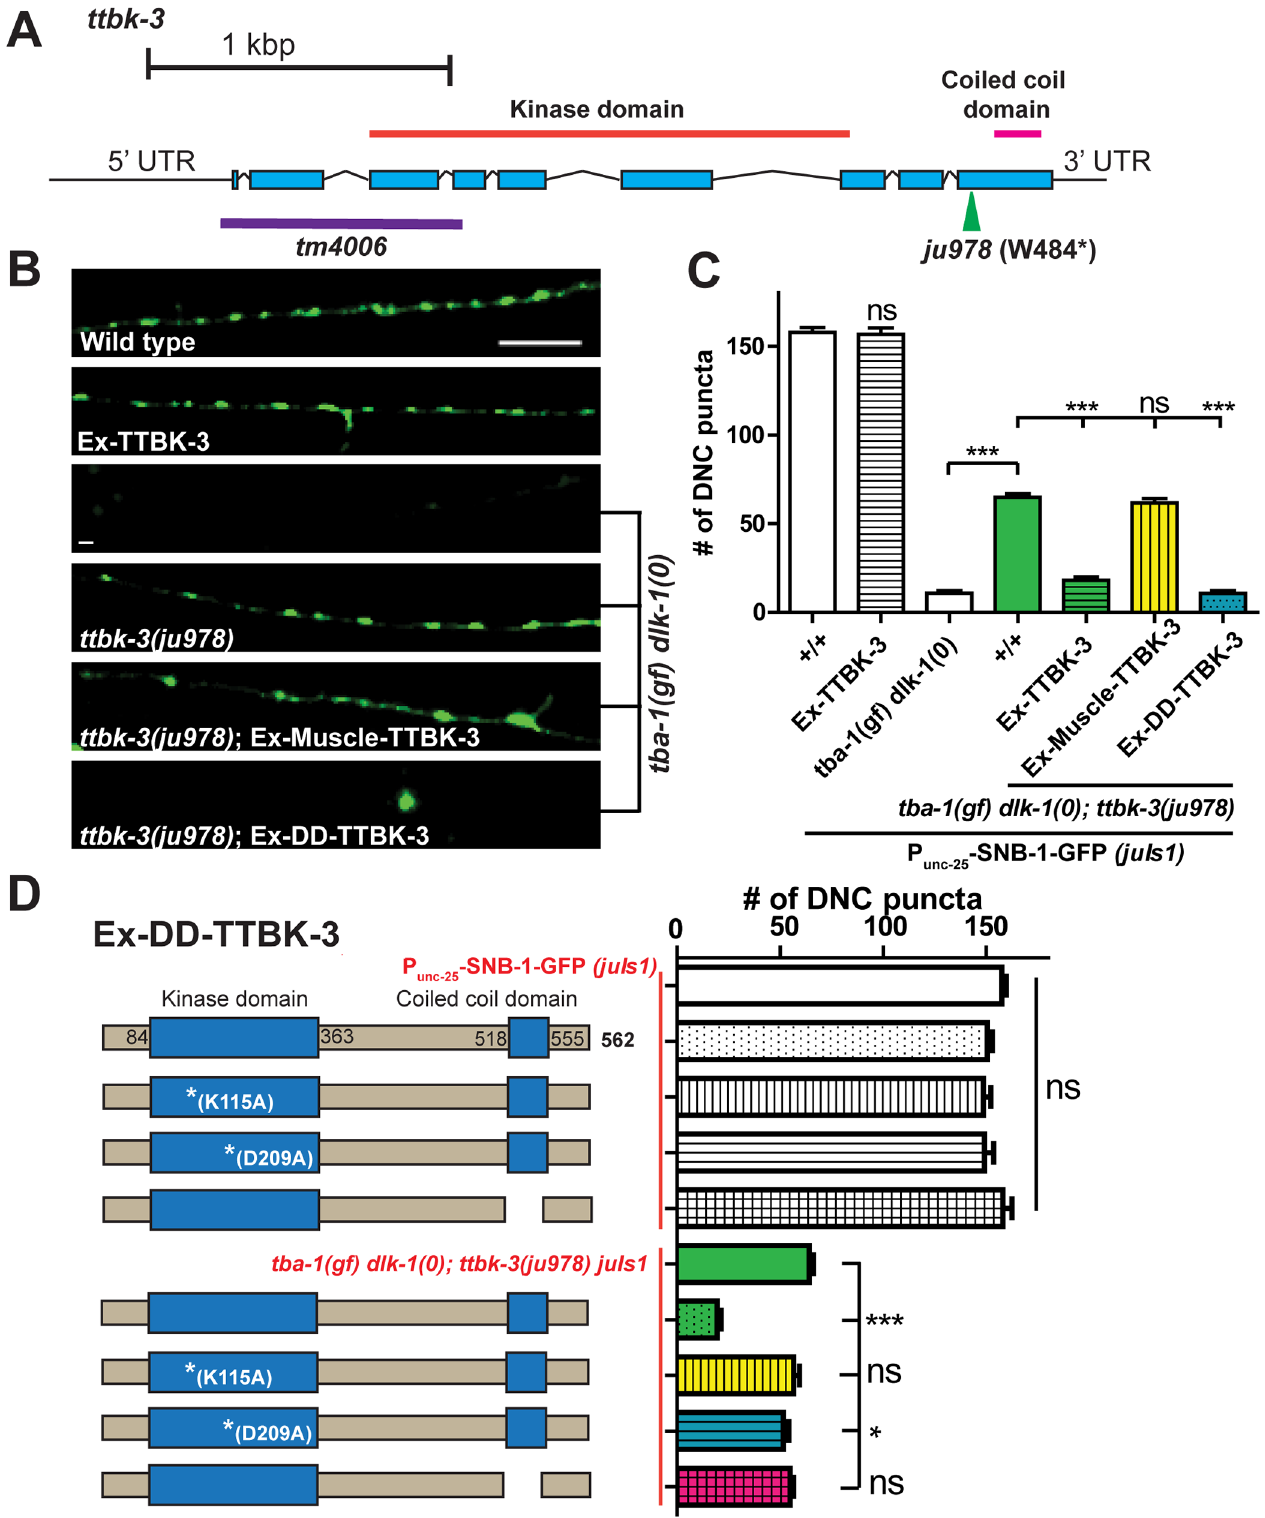
Fig 4. Kinase activity of ttbk-3 is required for suppressing tba-1(gf) dlk-1(0) . (A) Gene structure of ttbk-3 , with ju978 and the deletionallele tm4006 marked. (B) Representative images of DD neuronsynapses along the DNC in adult animalsimagedusing P unc-25 -SNB-1-GFP ( juIs1 ). Ex-